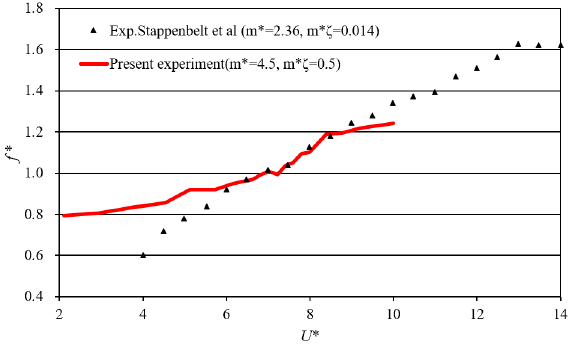
Figure 11. Comparison of vortex-induced vibration frequency responses of cylinders with different mass and damping parameters [14].